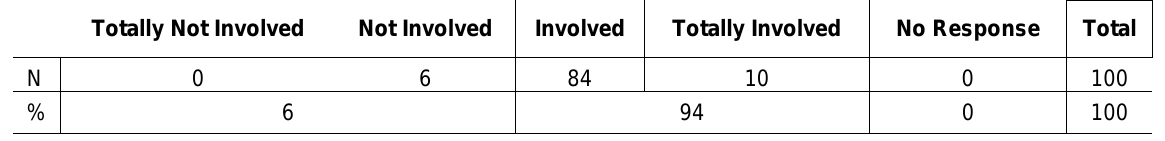
Instructors’ Ratings of the Secondary 1 Curriculum (N and